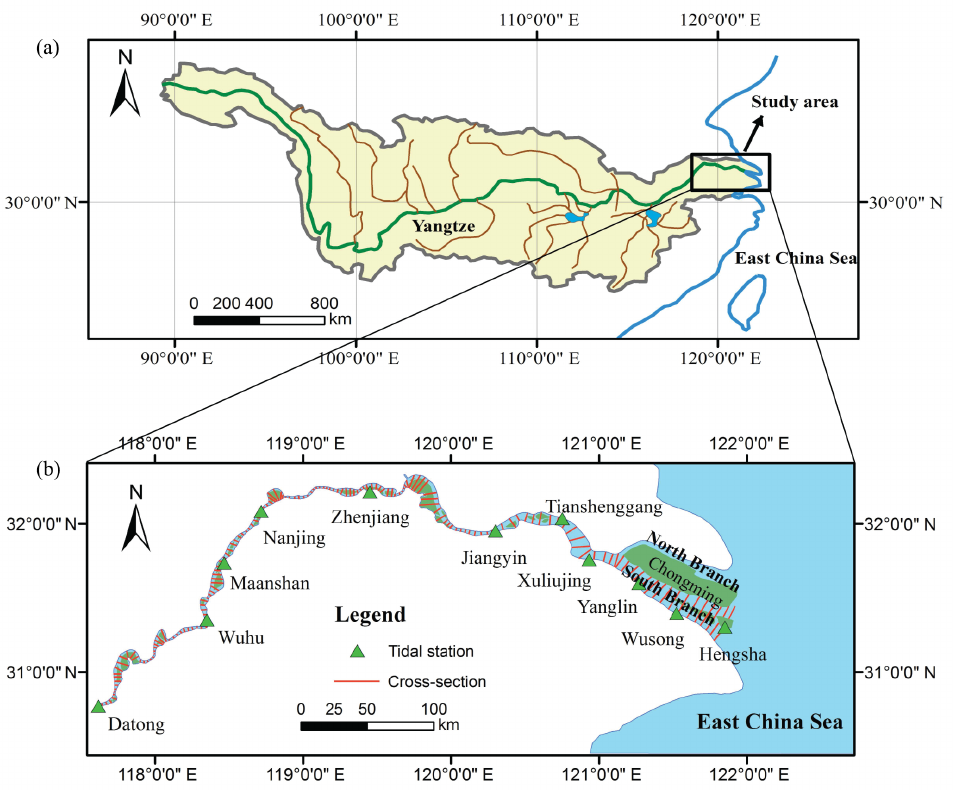
Figure 6. Location of the study area (a) and sketch of the Yangtze estuary showing the positions of the tidal stations and the cross sections extracted along the estuary (b)